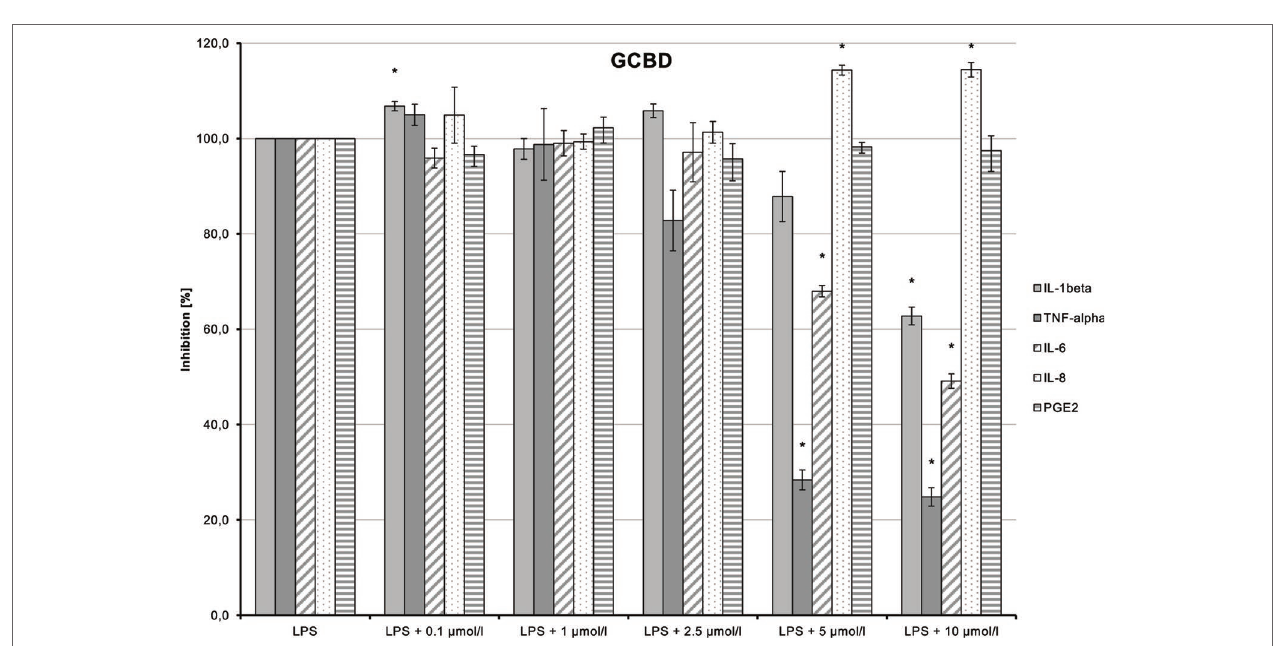
NMSC ( 6 ) enhanced the LPS-induced synthesis of IL-1β, which suggests an immunity-enhancing effect of the compound ( Figure 15 ). Concomitantly, LPS-induced releases of TNF-α, IL-8, and PGE were significantly reduced. 2